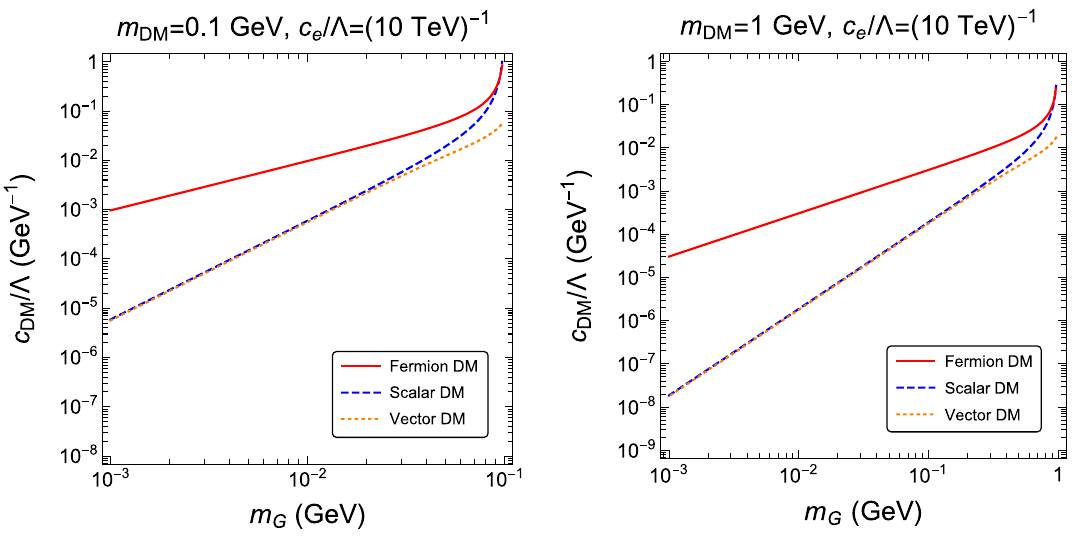
ter, respectively. We took m DM = 0 . 1 , 1GeV on left and right plots, respectively, and c e /(cid:3) = ( 10TeV ) − 1 for both plots